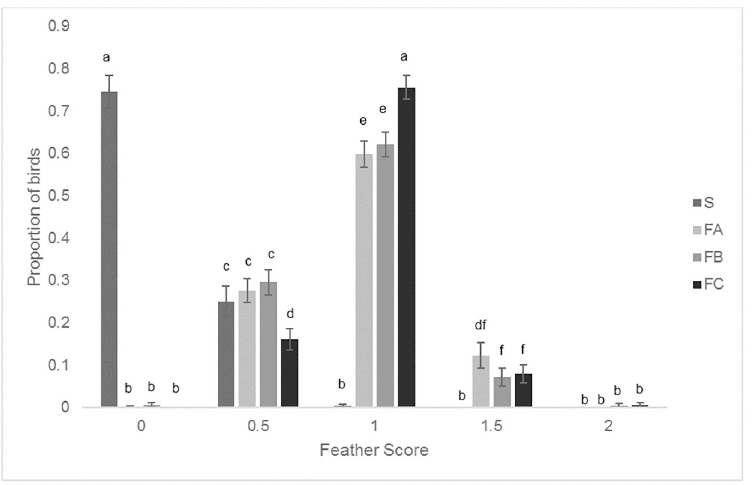
S birds had a higher proportion of lower gait scores than the other breeds and FC had more GS1 and fewer GS3 than FA and FB (Wald = 22.24, P < 0.001) (Fig 2). 15 Feather cover score. Males had a larger proportion of poorer feather scores than females. In particular, males had a larger proportion of feather score 1.5 than females (Score 1.5: Mean proportion ± SEM, Males: 0.10 ± 0.02, Females: 0.03 ± 0.009, F = 5.14, P < 0.001). 4, 544 S birds had significantly higher proportions of lower (better) feather scores than the other breeds and FC birds had higher proportions of higher (worse) feather scores than the FA and FB birds (F = 153.23, P < 0.001) (Fig 3). 12, 544 Breast feather cleanliness score. Overall, males had a larger proportion of higher (worse) breast cleanliness scores than females, specifically they had fewer score 1’s and more score 2’s than females indicating dirtier breasts (F = 6.88, P = 0.001) and the proportions of higher 6, 320